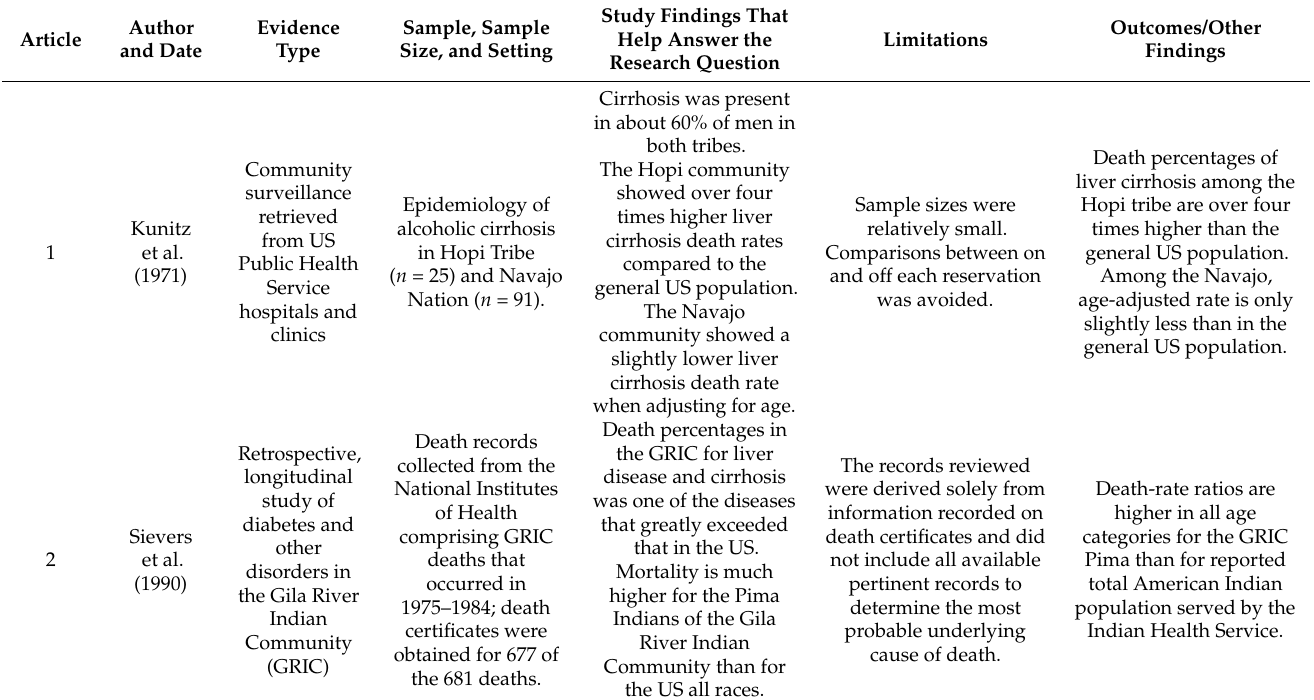
Table 2. Study characteristics of included